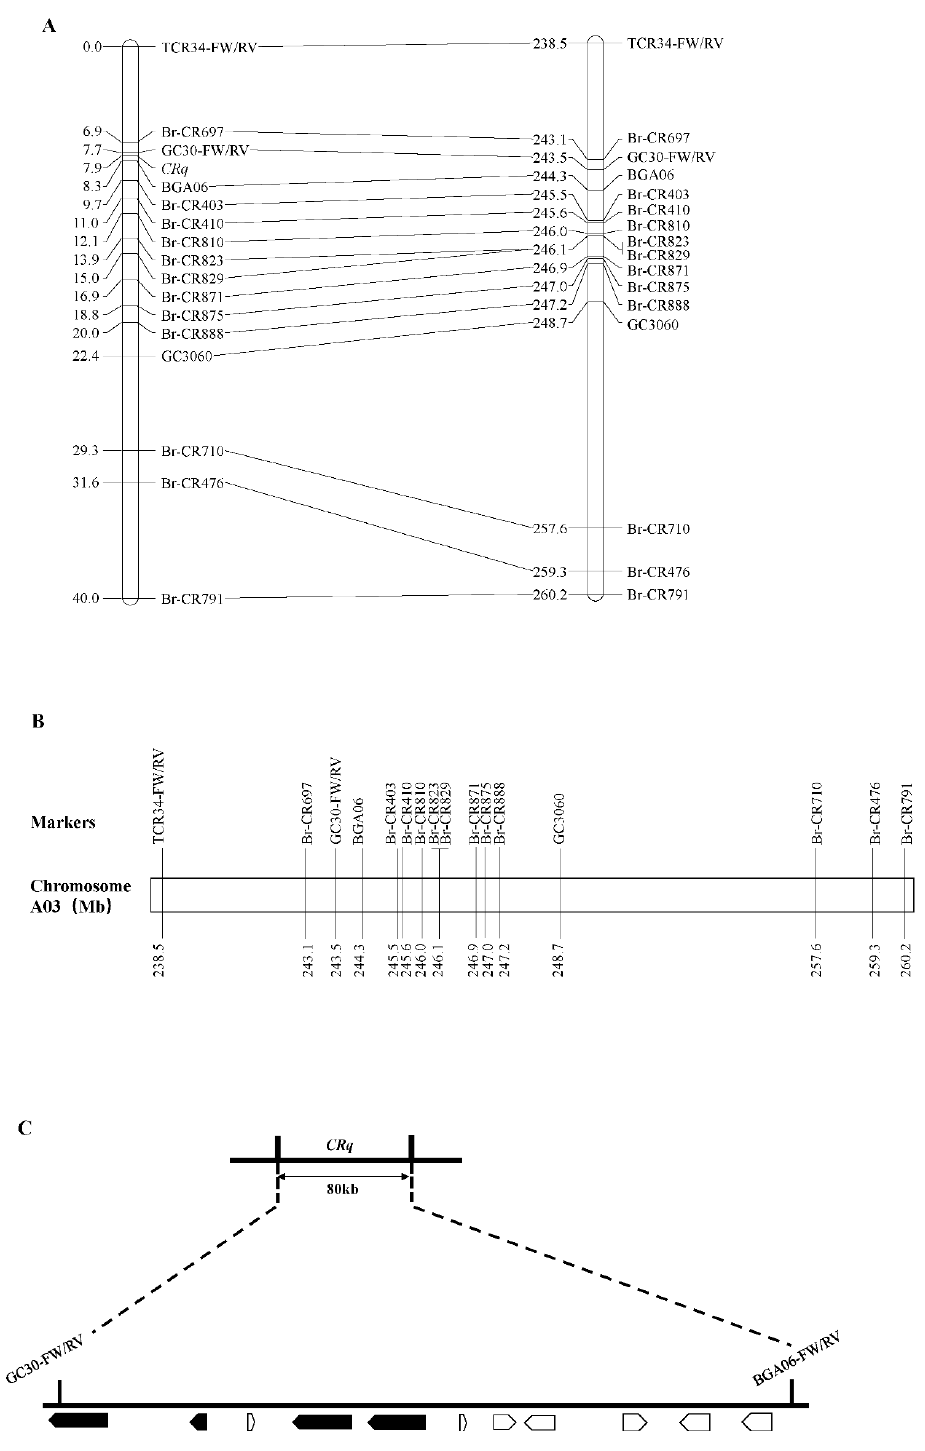
Figure 2. Initial and fine mapping of the CRq gene in Chinese cabbage. ( A ) Initial mapping of CRq region. Genetic map of CRq is on the left, with cM as the unit. The corresponding physical maps (right, unit: Mb) are also shown. ( B ) Fine mapping of CRq . ( C ) The CRq gene was delimited to an interval between GC30-FW/RV and BGA06, with an estimated length of 80 kb, where 11 genes were annotated based on the reference genome sequence. The genetic structure is depicted as white for meaningless genes, and black for the R gene, respectively. Physical map of the CRq region in B. rapa reference genome